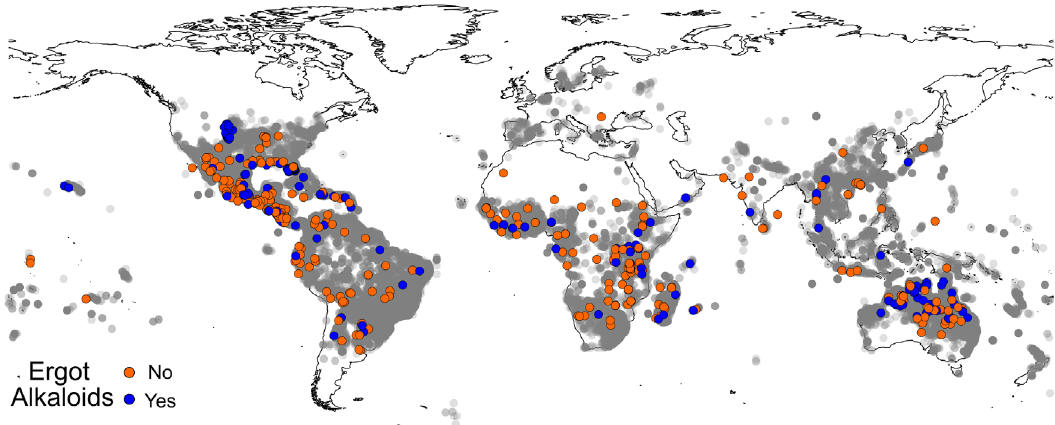
Fig. 1 Geography of samples. Global distribution of samples tested for EAs ( n = 723). Gray circles represent herbarium specimens from Argyreia, Ipomoea, Stictocardia , and Turbina (now Ipomoea ) species from the Global Biodiversity Information Facility 83 – 86 to illustrate the geographical distribution of the tribe Ipomoeeae with higher concentrations of sample in